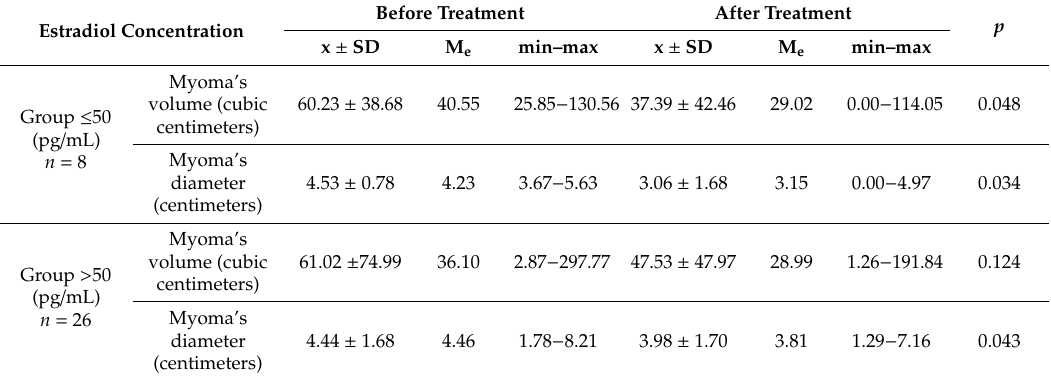
Table 5. The diameter and volume of fibroids before and after 3 months of treatment with ulipristal acetate depending on the pretreatment estrogenic status of patients.